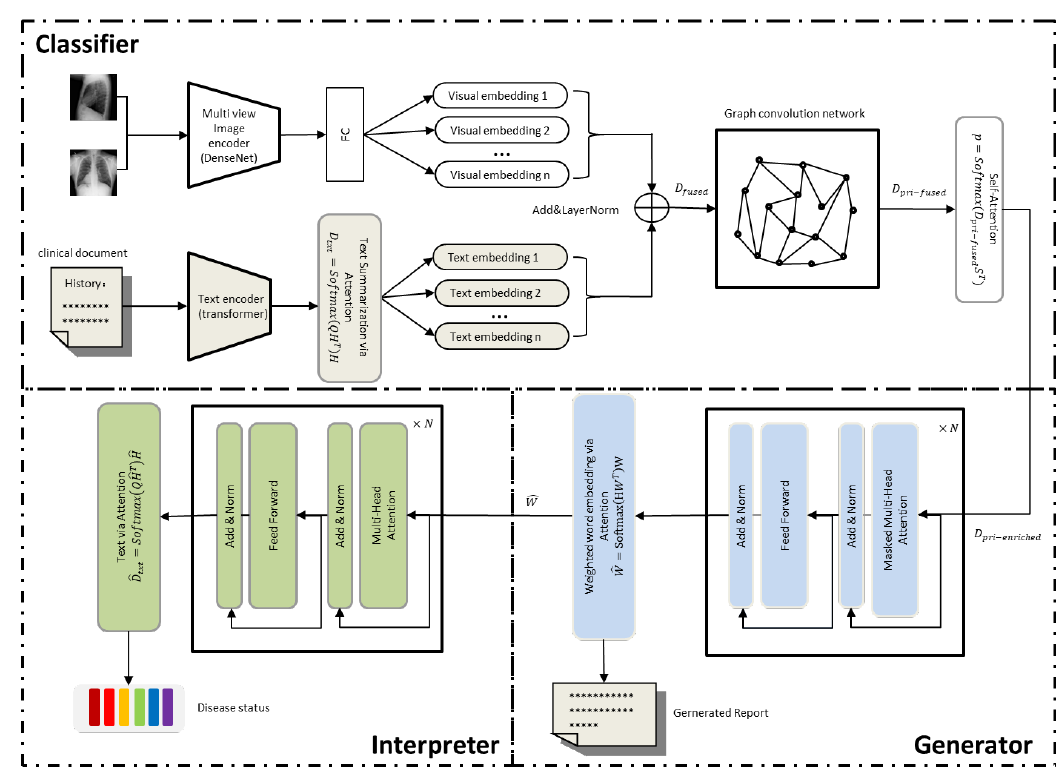
Figure 1. Our model mainly includes three parts. The classifier is used to read chest X-ray images and clinical history to extract visual features and text features, and then the image–text hybrid features and the adjacency matrix of the knowledge graph are passed into the graph convolutional network to obtain the features containing prior knowledge. The obtained features are combined with topic features and state features and fed into the generator based on the visual self-attention model to generate the radiology report. The generated report is then passed into the interpreter to adjust the generated radiology report.